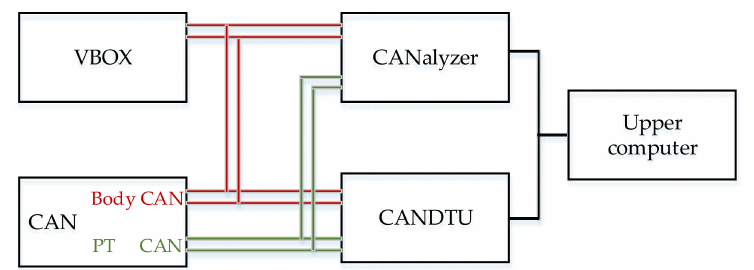
Figure 3. The schematic of data collection.